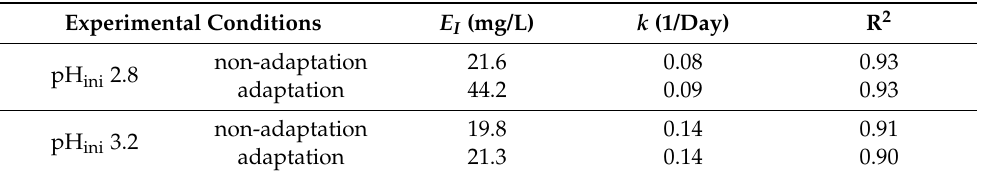
Table 1. The maximum leaching concentration ( E I ) and leaching rate constant ( k ) calculated using Equation (1).